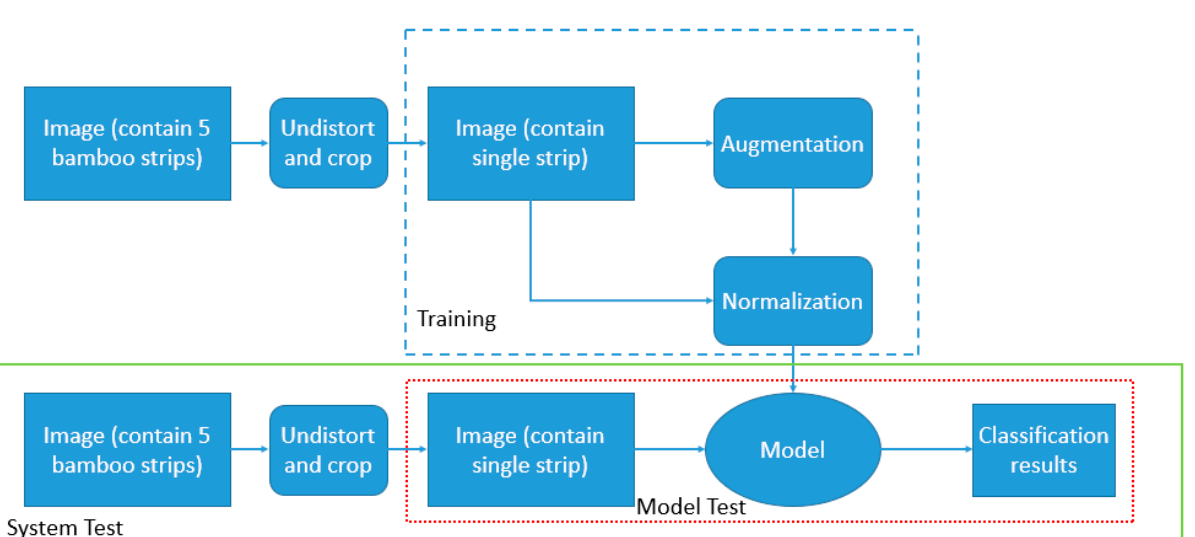
Figure 7. Bamboo dataset structure.